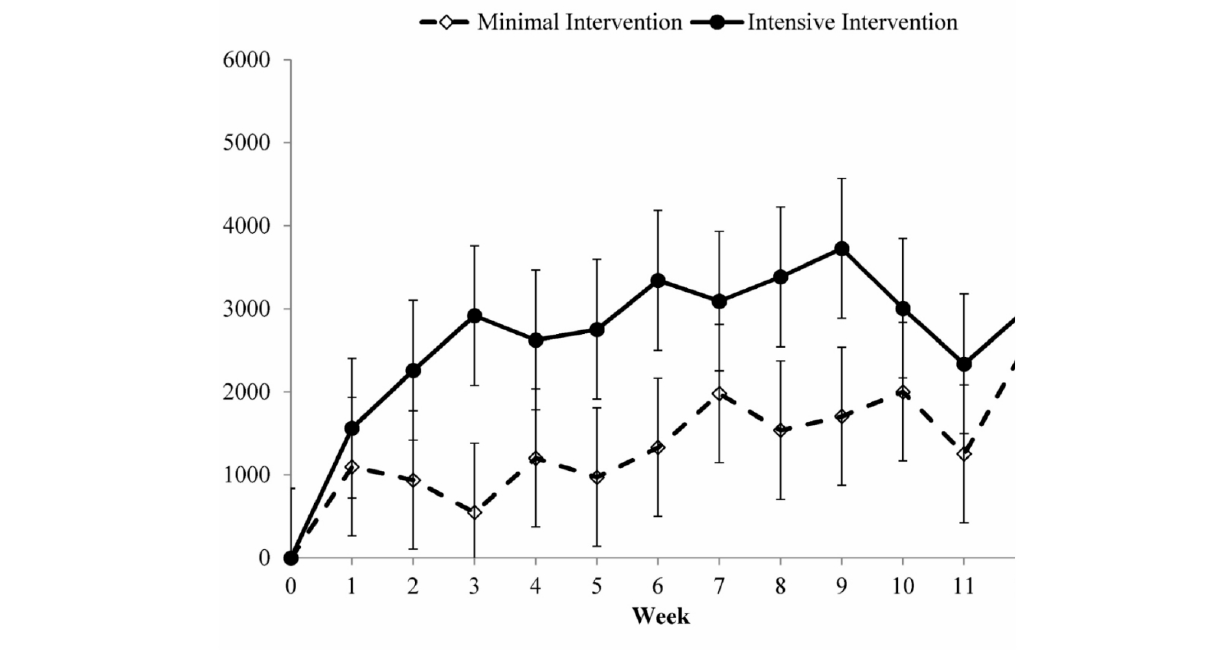
Figure 6. Average change in child’s steps per week by intervention